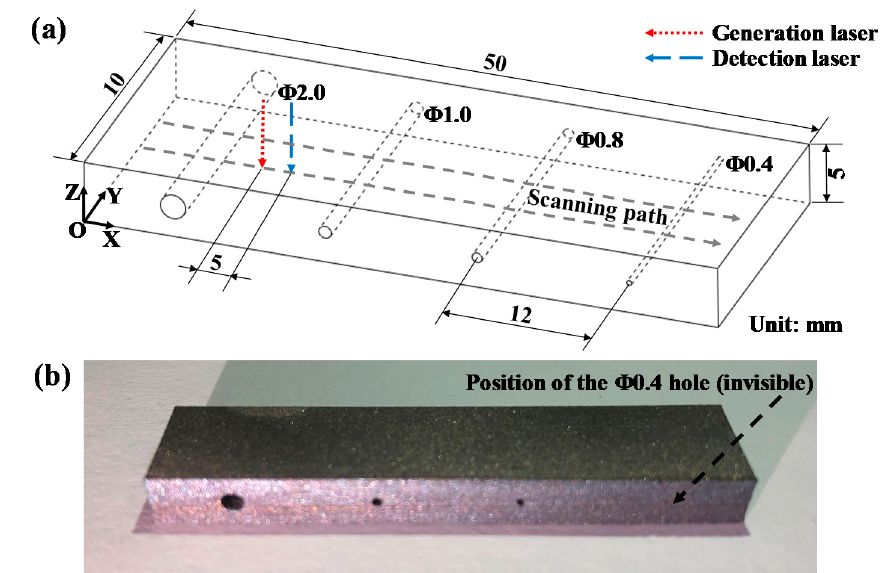
Figure 3. The investigated sample: ( a ) sketch of CAD model and ( b ) photography of the AM sample.